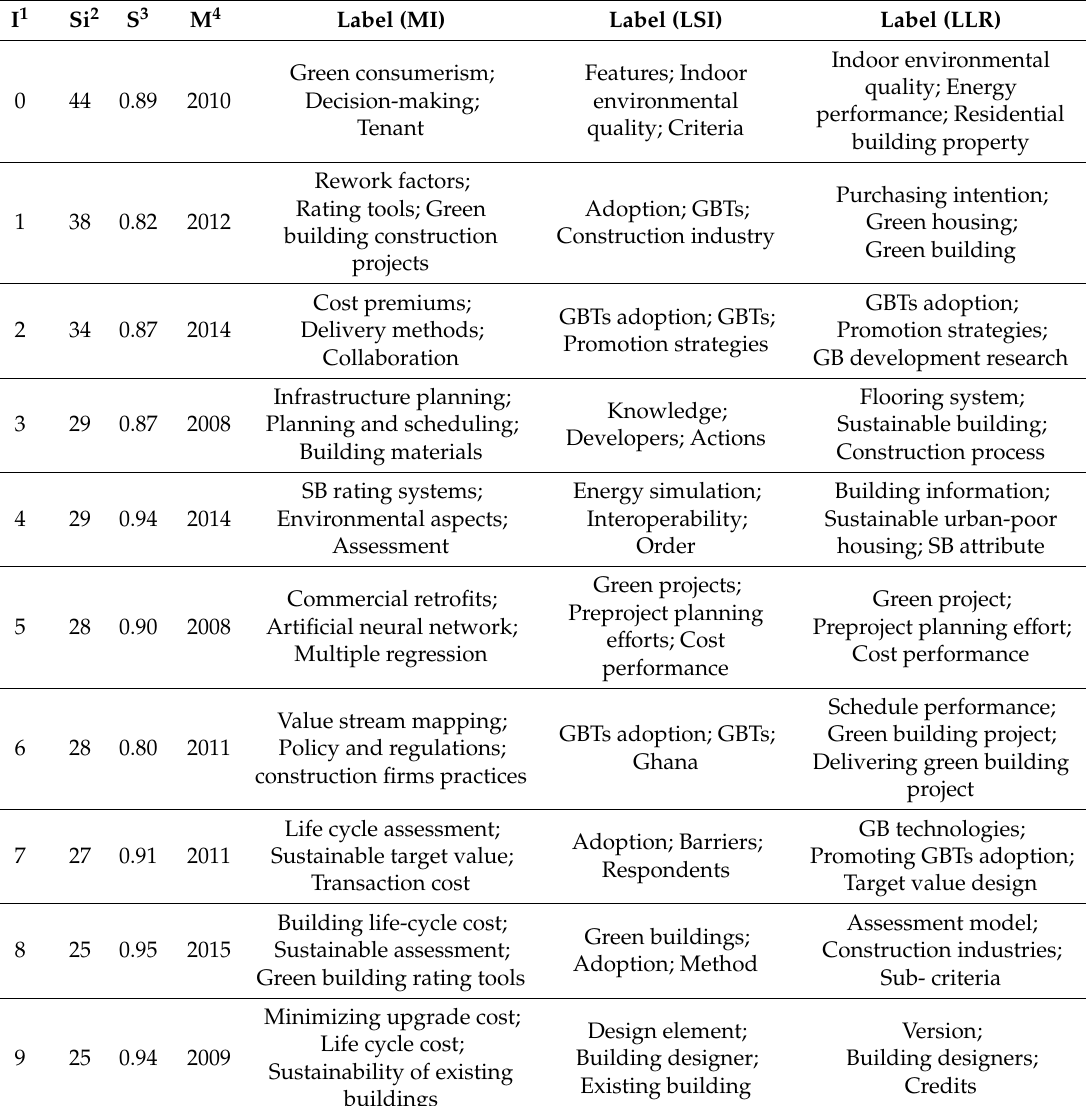
Table 3. Top ranked cluster and labels produced by LSI, LLR, and